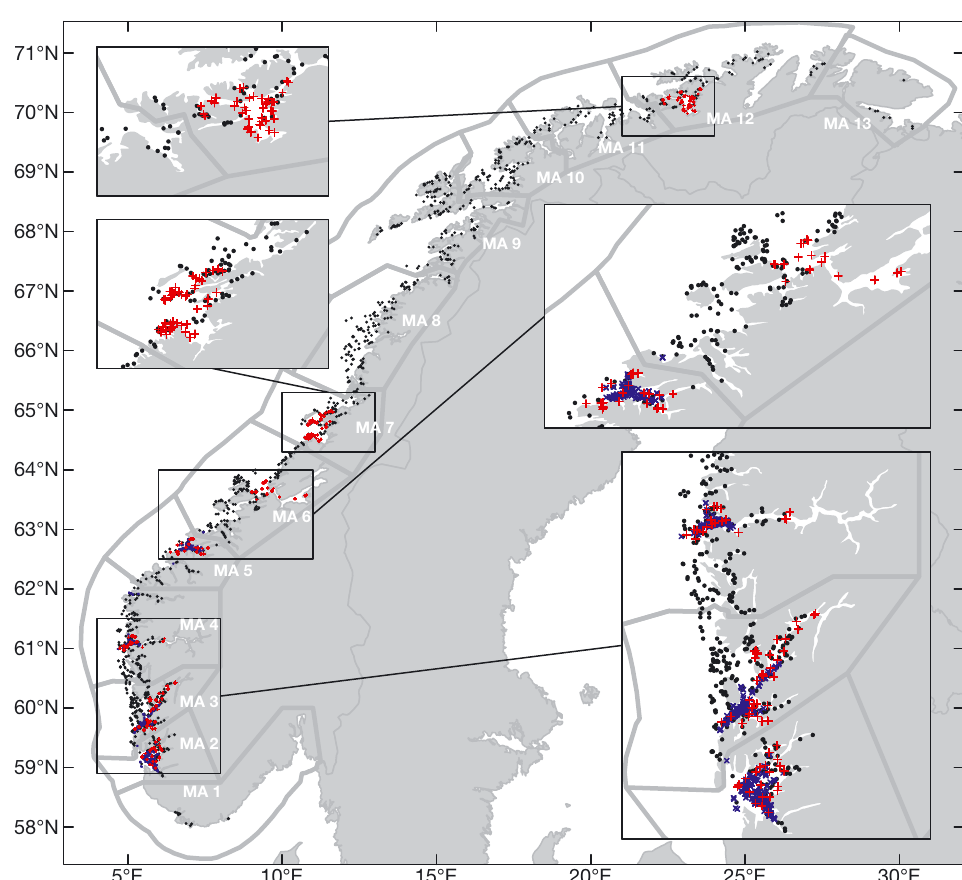
Fig. 1. Study area on the Norwegian coast, divided into 13 management areas (MA 1 to MA 13). Black dots: active salmonid farms in the period 2012–2021; red crosses: locations of sentinel cage experiments; blue crosses: mid-points of post-smolt trawl